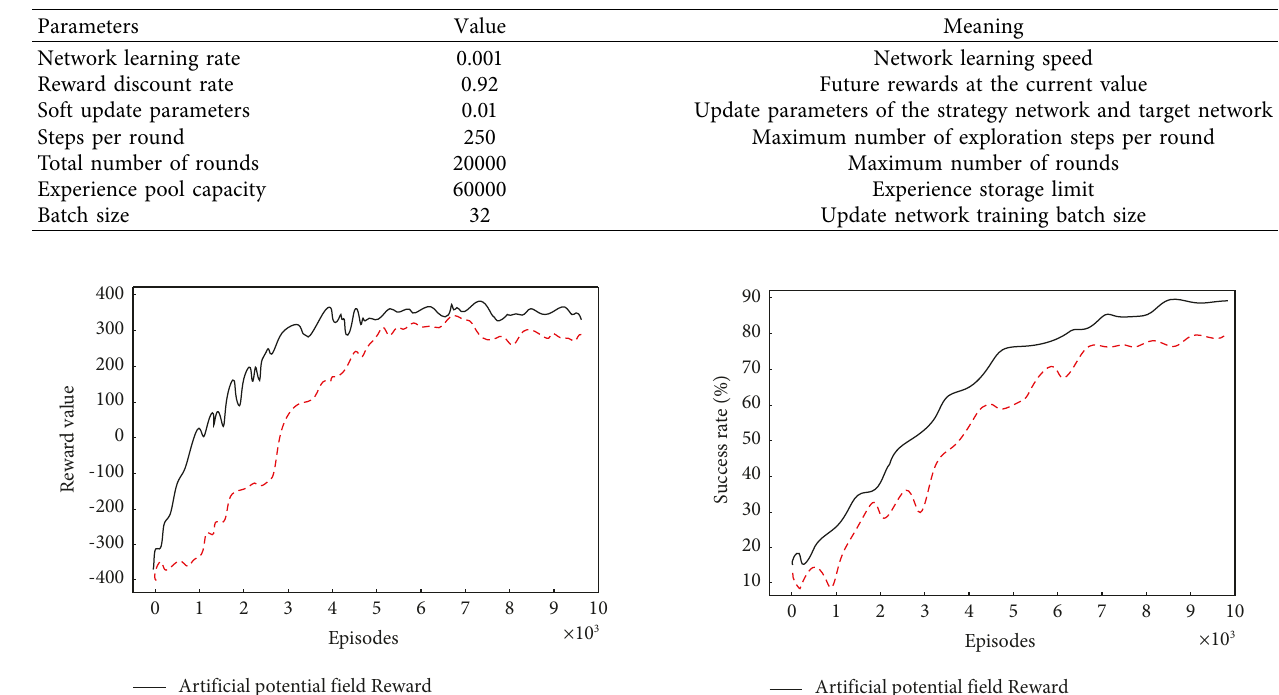
Table 1: Neural network-related parameter settings.